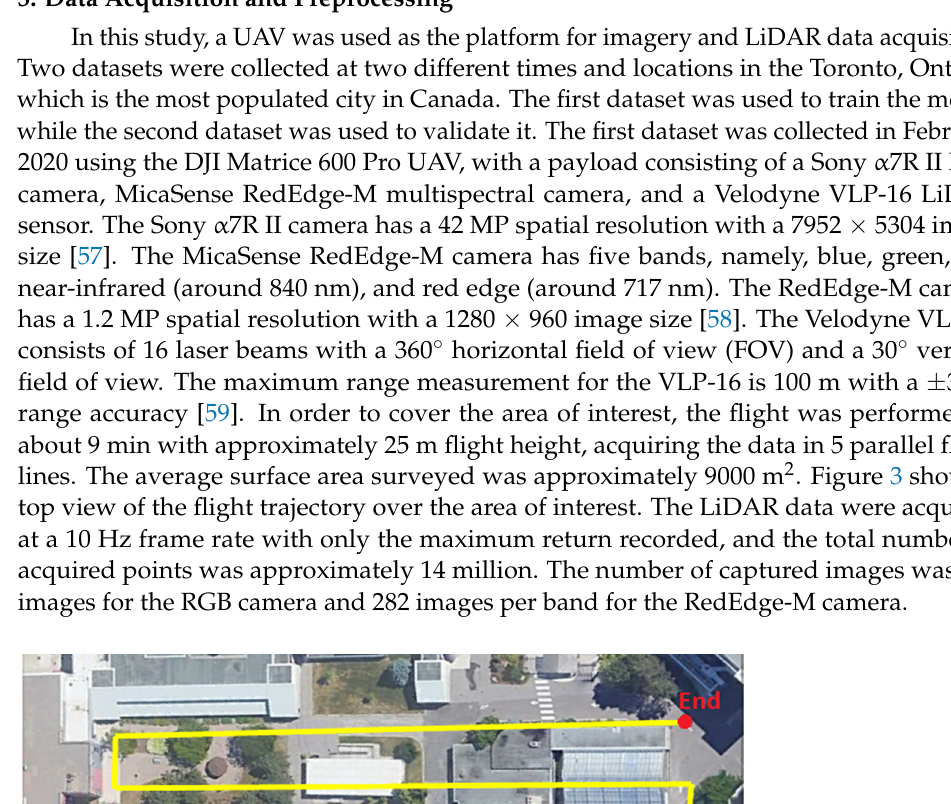
Figure 4. First study area with red and yellow squares highlighting the GCP positions. G1 through G12 represent the ground control points (GCPs) and check points.